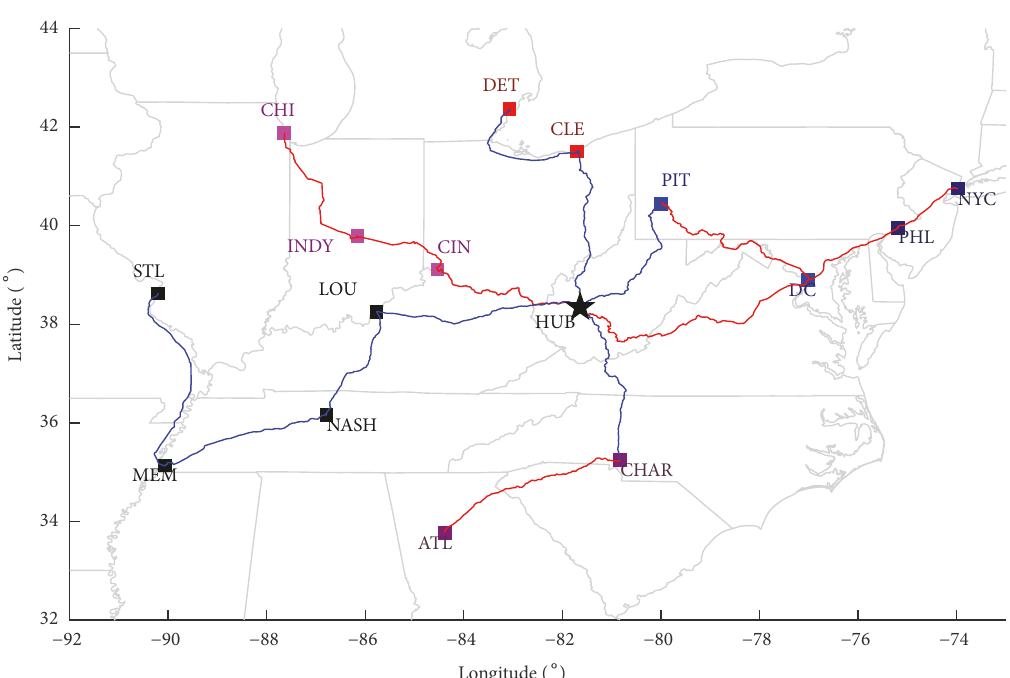
Figure 7: Solution 3 of mass transit system showing mode of transportation: red = train; blue =